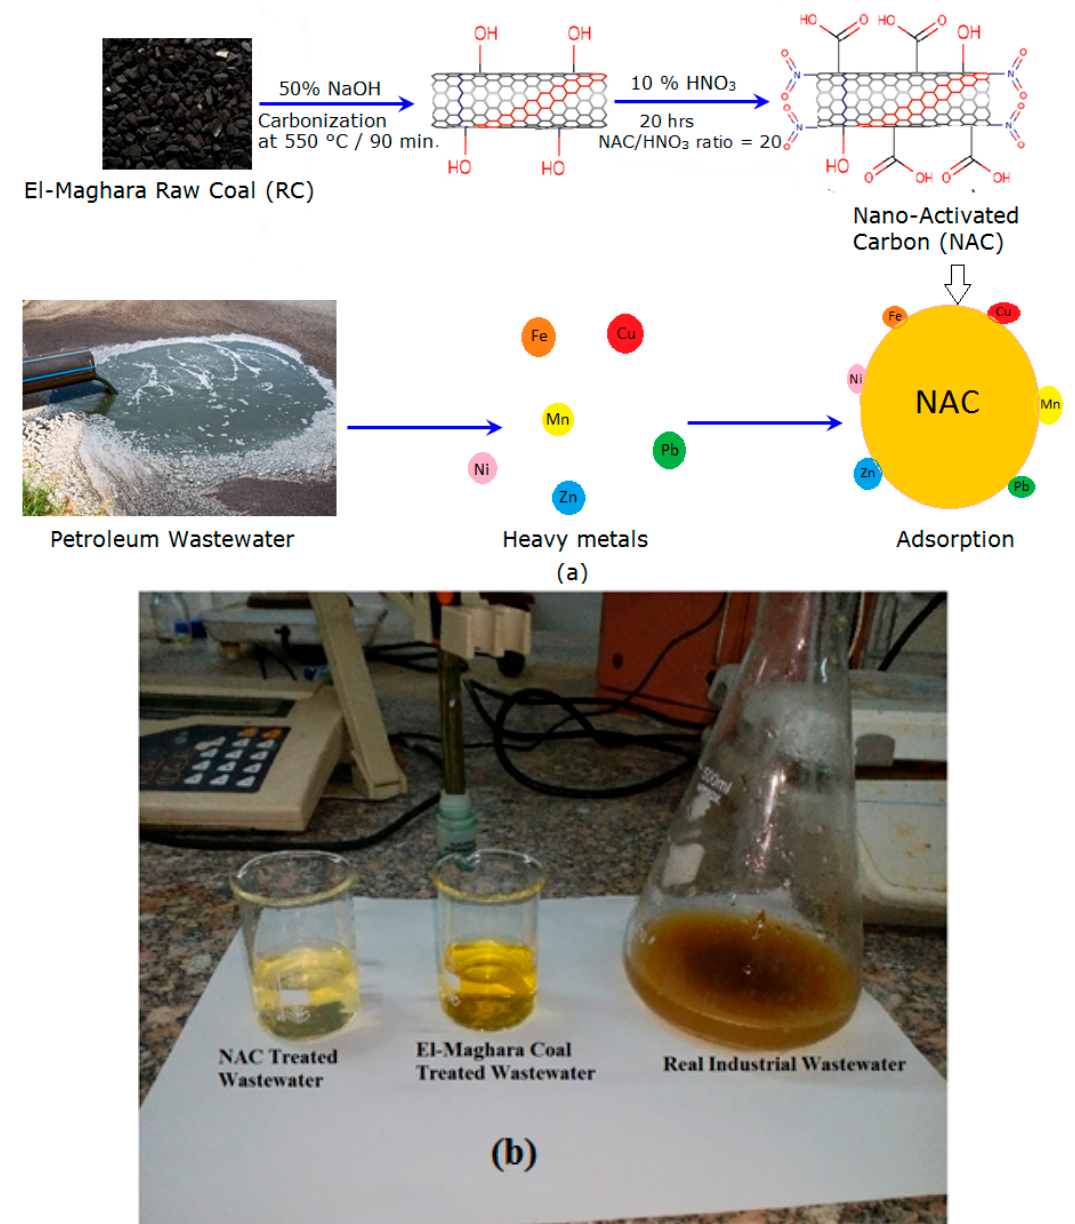
Figure 1. ( a ) Schematic representation of the chemical modification of El-Maghara coal for nano- activated carbon (NAC) fabrication, and ( b ) Digital image of the real industrial wastewater before